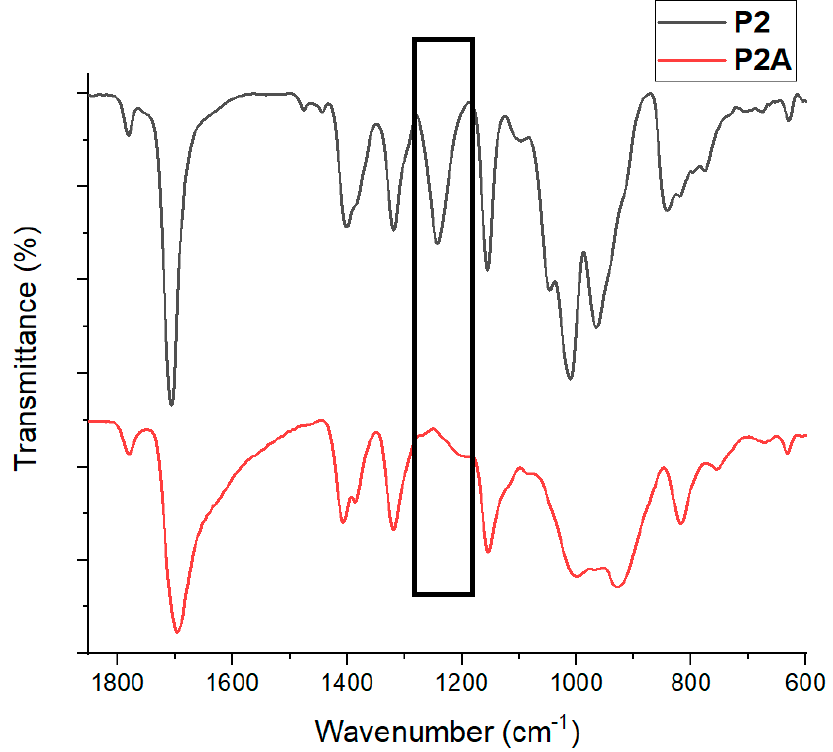
Figure 2. FT-IR spectra of P2 and P2A .